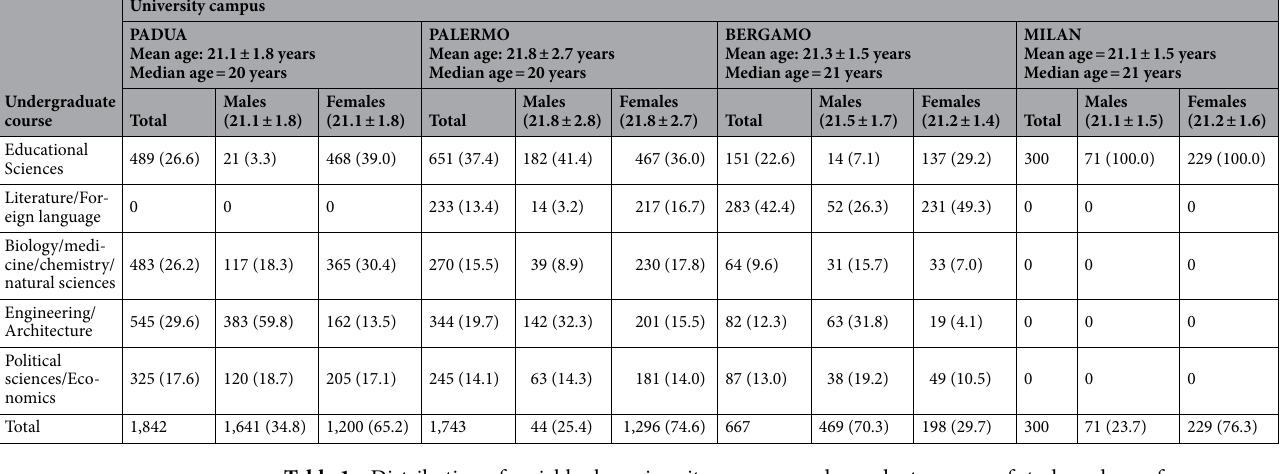
Table 1. Distribution of variables by university campus, undergraduate course of study and sex of interviewees. 8 missing values for sex: 1 for Padua campus, 7 for Palermo campus. Yrs = years. Number (N), percentage